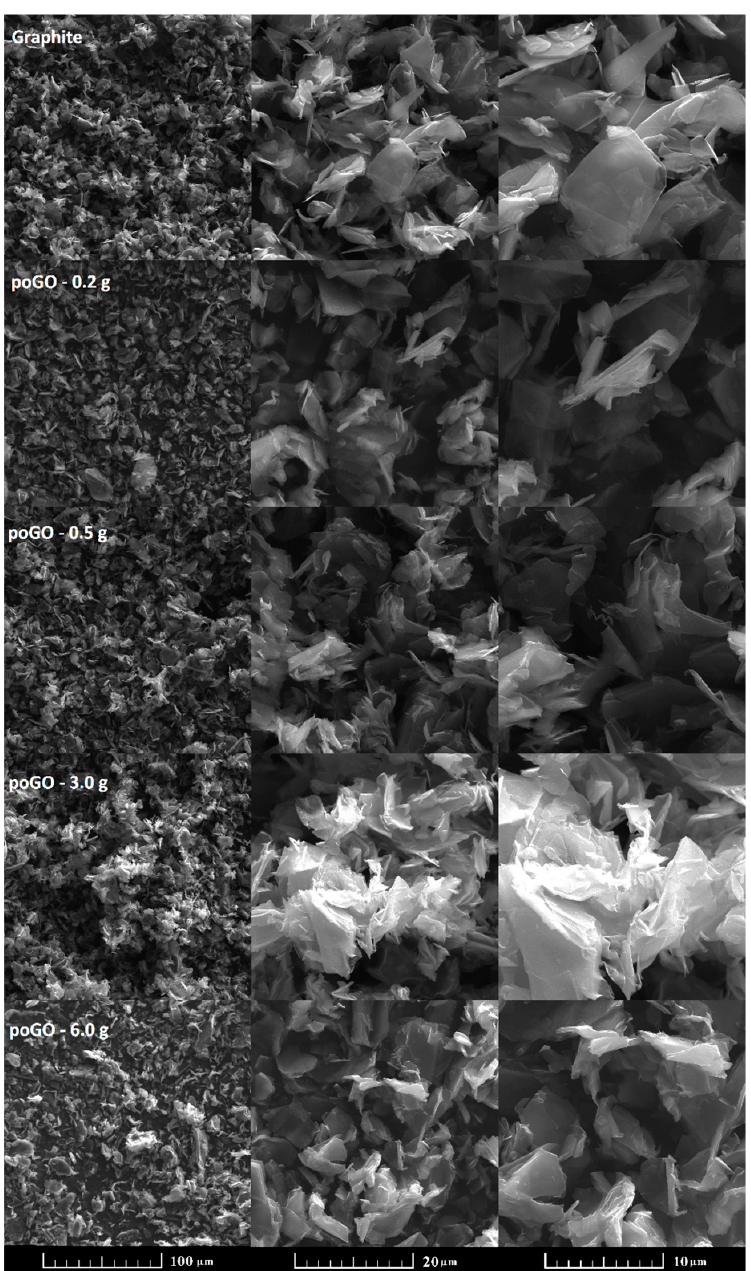
Figure 1. Micrographs of partially oxidized graphites poGOs.